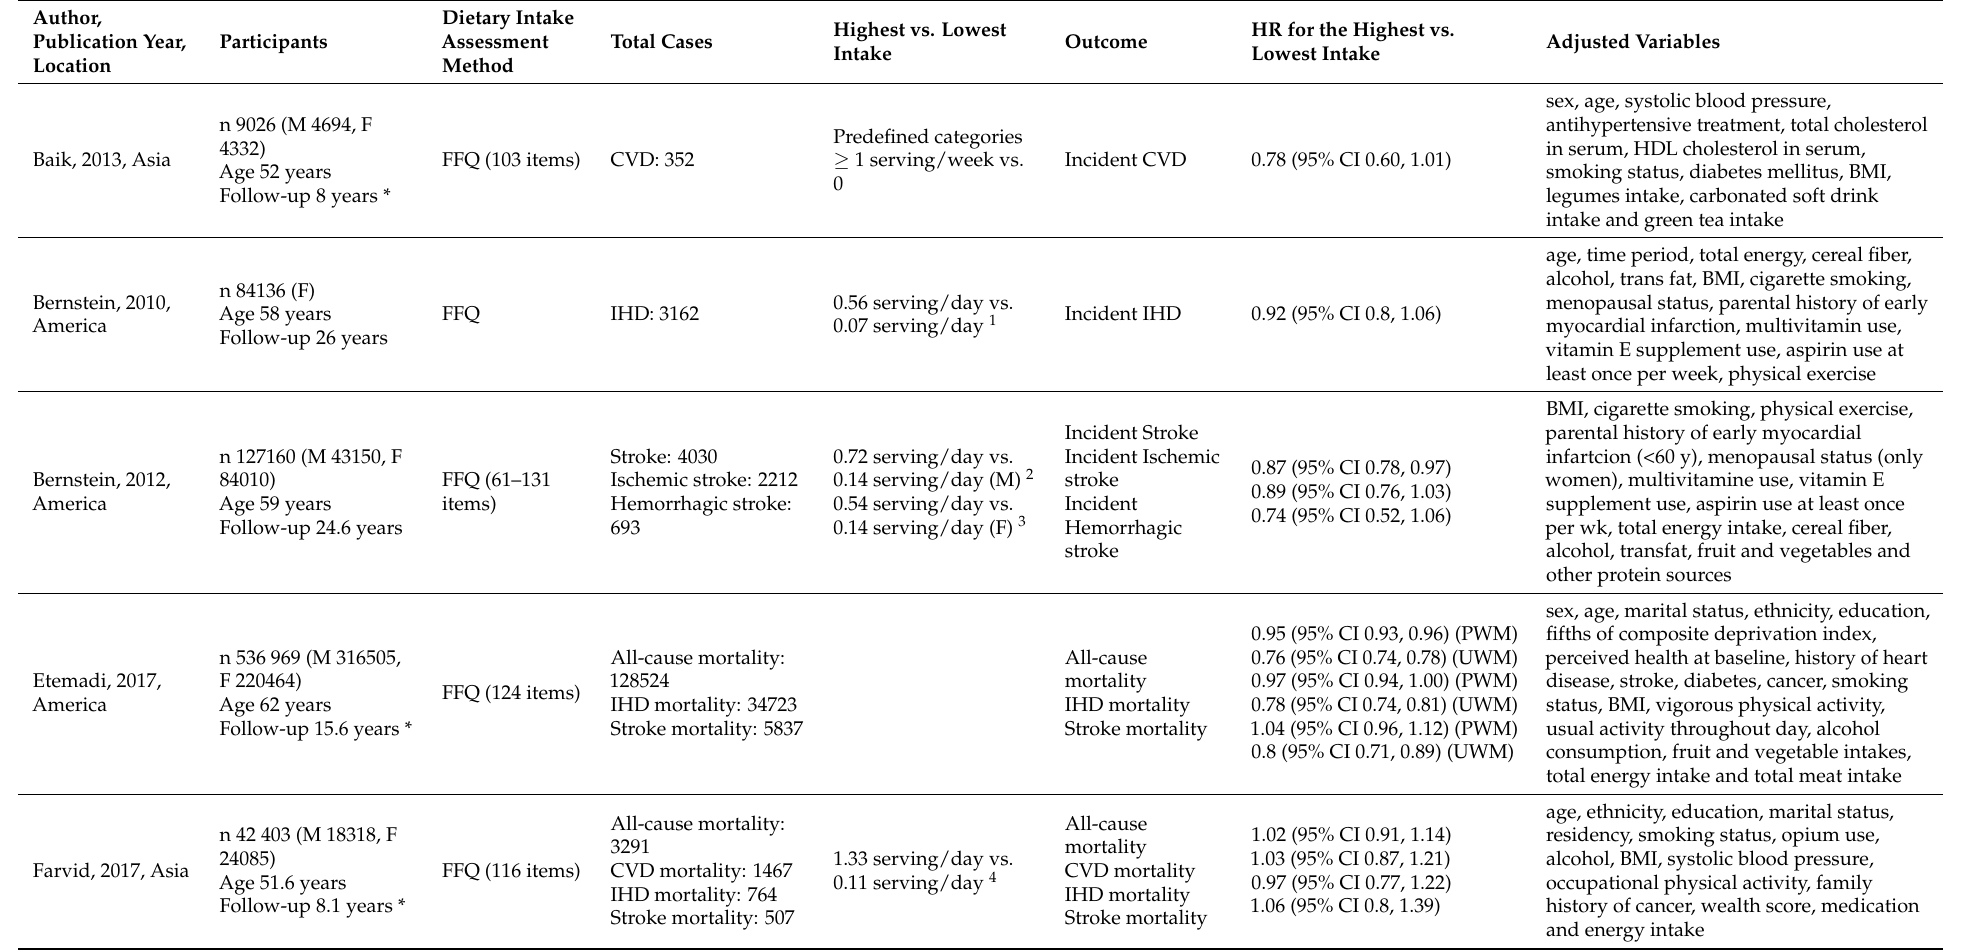
Table 1. Characteristics of the prospective cohort studies included in the